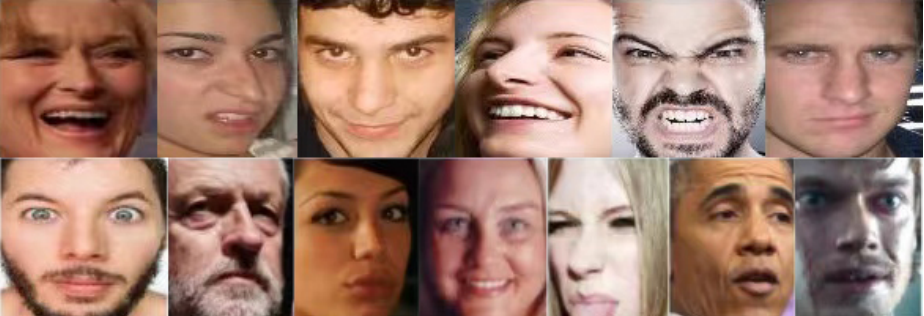
Figure 7. Sample images from RAF-DB and AffectNet datasets. We use the Retinaface algorithm to detect the location rectangle of the face and the location map of the five key points of the face. We calculate the angle to be converted via the positions of the center points of the left and right eyes and then align the face using affine transformations. The alignment effect is shown in the above figure.